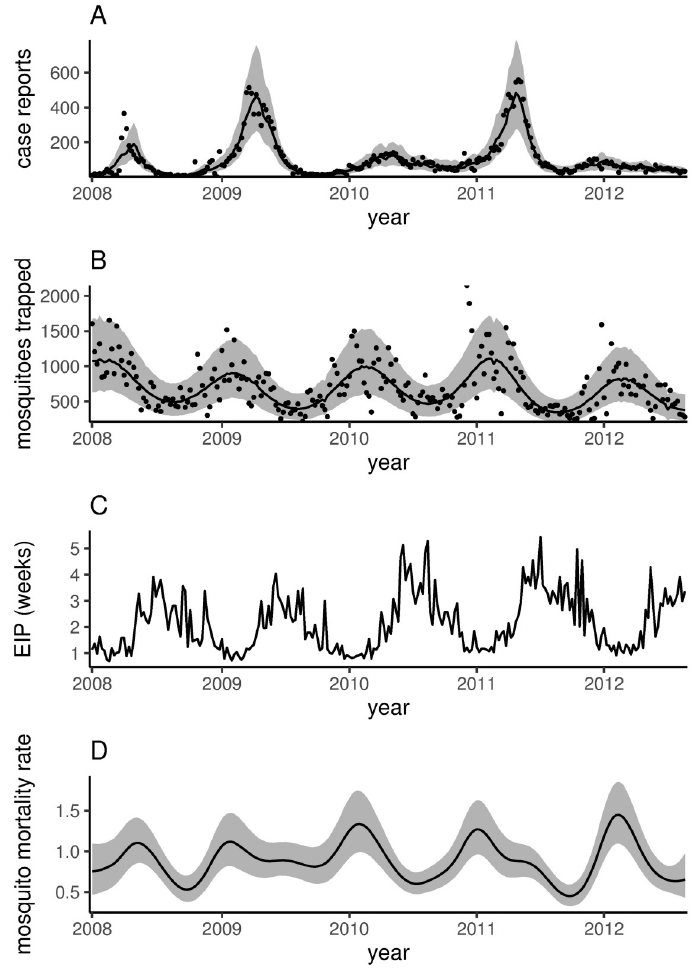
Fig 1. Vito´ria data and model estimates. A: weekly observed case reports (points), with corresponding posterior median (black line) and 80% posterior credible interval (gray band). B: weekly mosquito trap counts (points), with posterior median (black line) and 80% posterior credible interval (gray band). C: extrinsic incubation period (EIP; weeks), computed from weekly mean temperature data. D: estimated weekly mosquito mortality rate, with the posterior median (black line) and the 80% posterior credible interval (gray